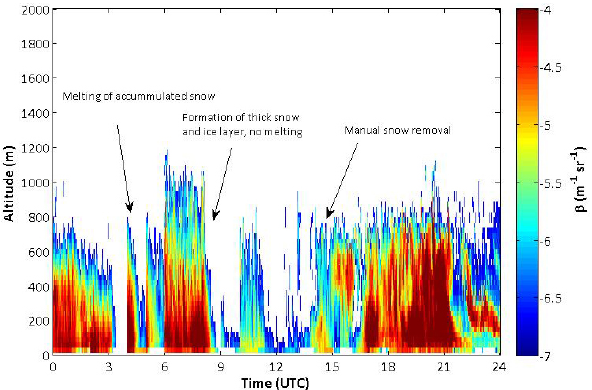
Fig. 4. Effect of snow on Doppler lidar attenuated backscatter profiles in Helsinki on 4 February 2012. Snowfall rate was rea- sonably constant throughout the day, according to weather radar